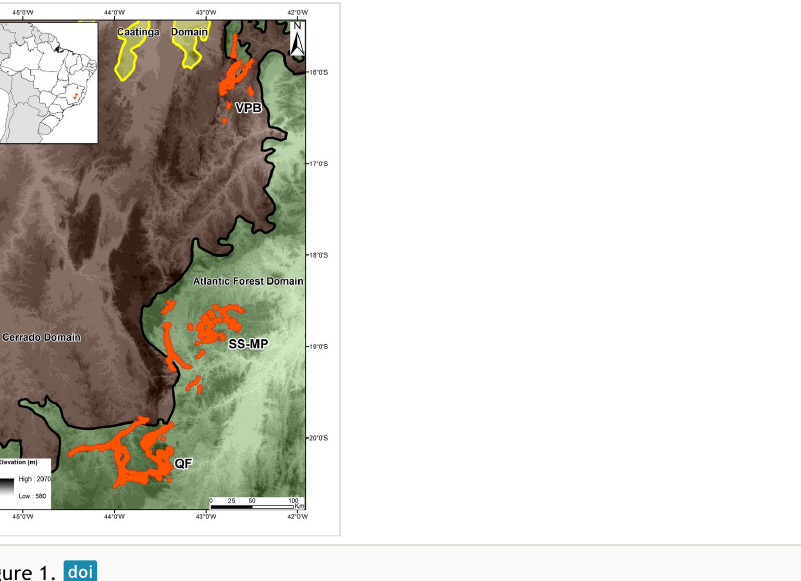
Ironstone ranges, south-eastern Brazil (orange polygons) as related to the Atlantic Rainforest and Cerrado phytogeographical domains. QF: Quadrilátero Ferrífero; SS-MP: Serra da Serpentina-Morro do Pilar; VPB: Peixe Bravo River Valley.